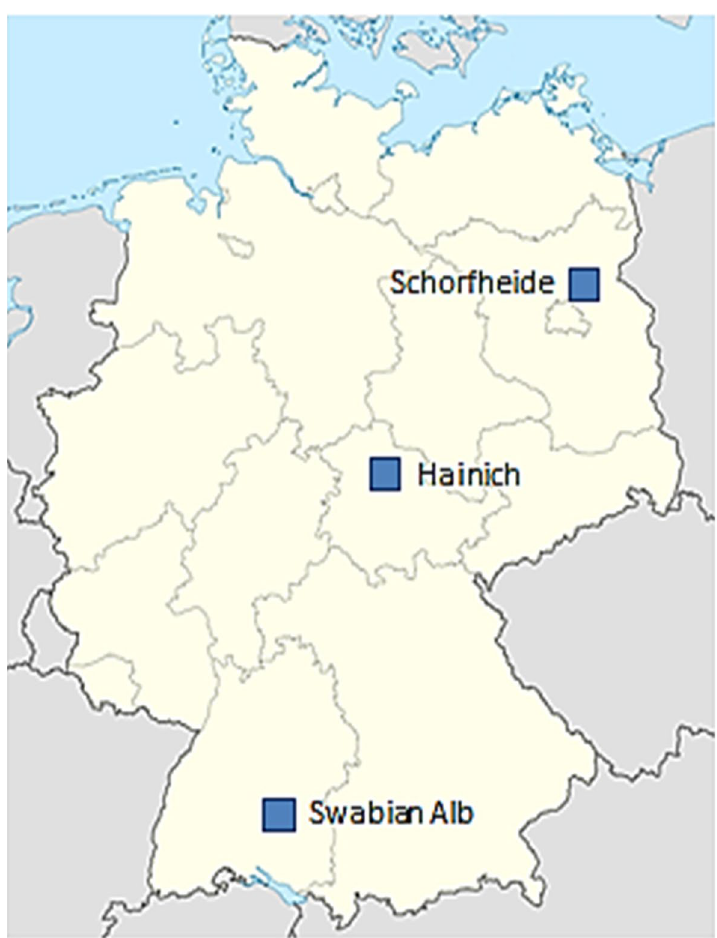
Fig. 1 Locations of the German biodiversity exploratories project in three regions of Germany: Schorfheide-Chorin (Brandenburg), Hainich-Dün (Thuringia) and Swabian Alb